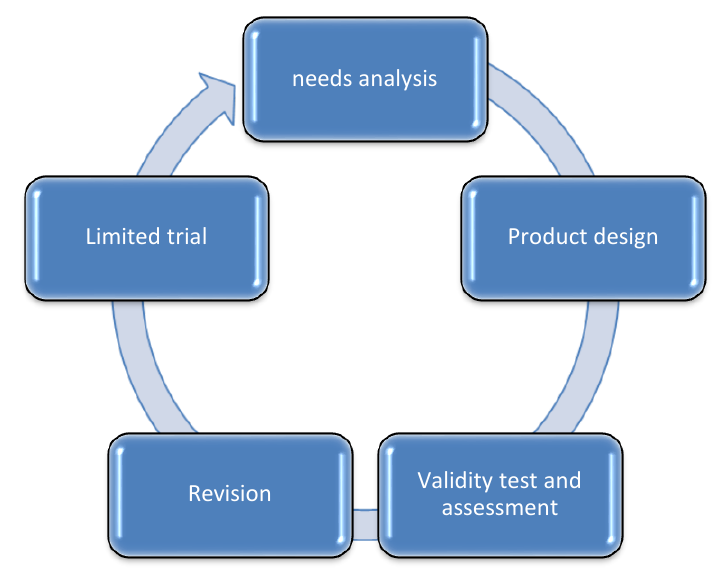
Figure 1. Product Development Process